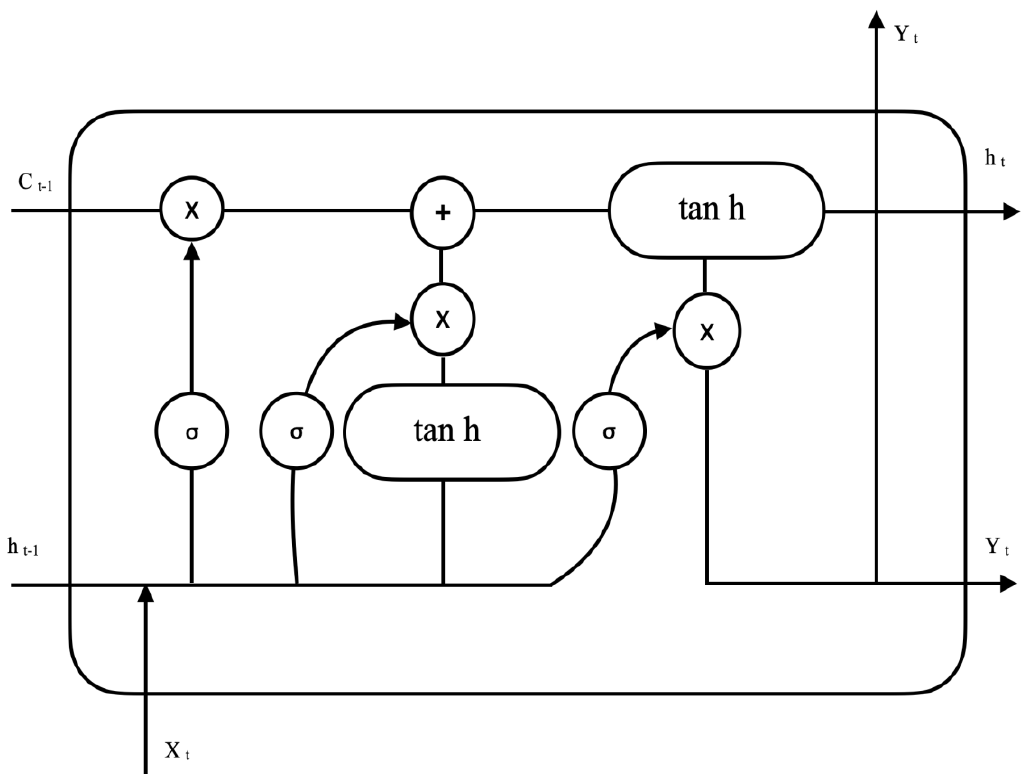
Figure 1. Single LSTM